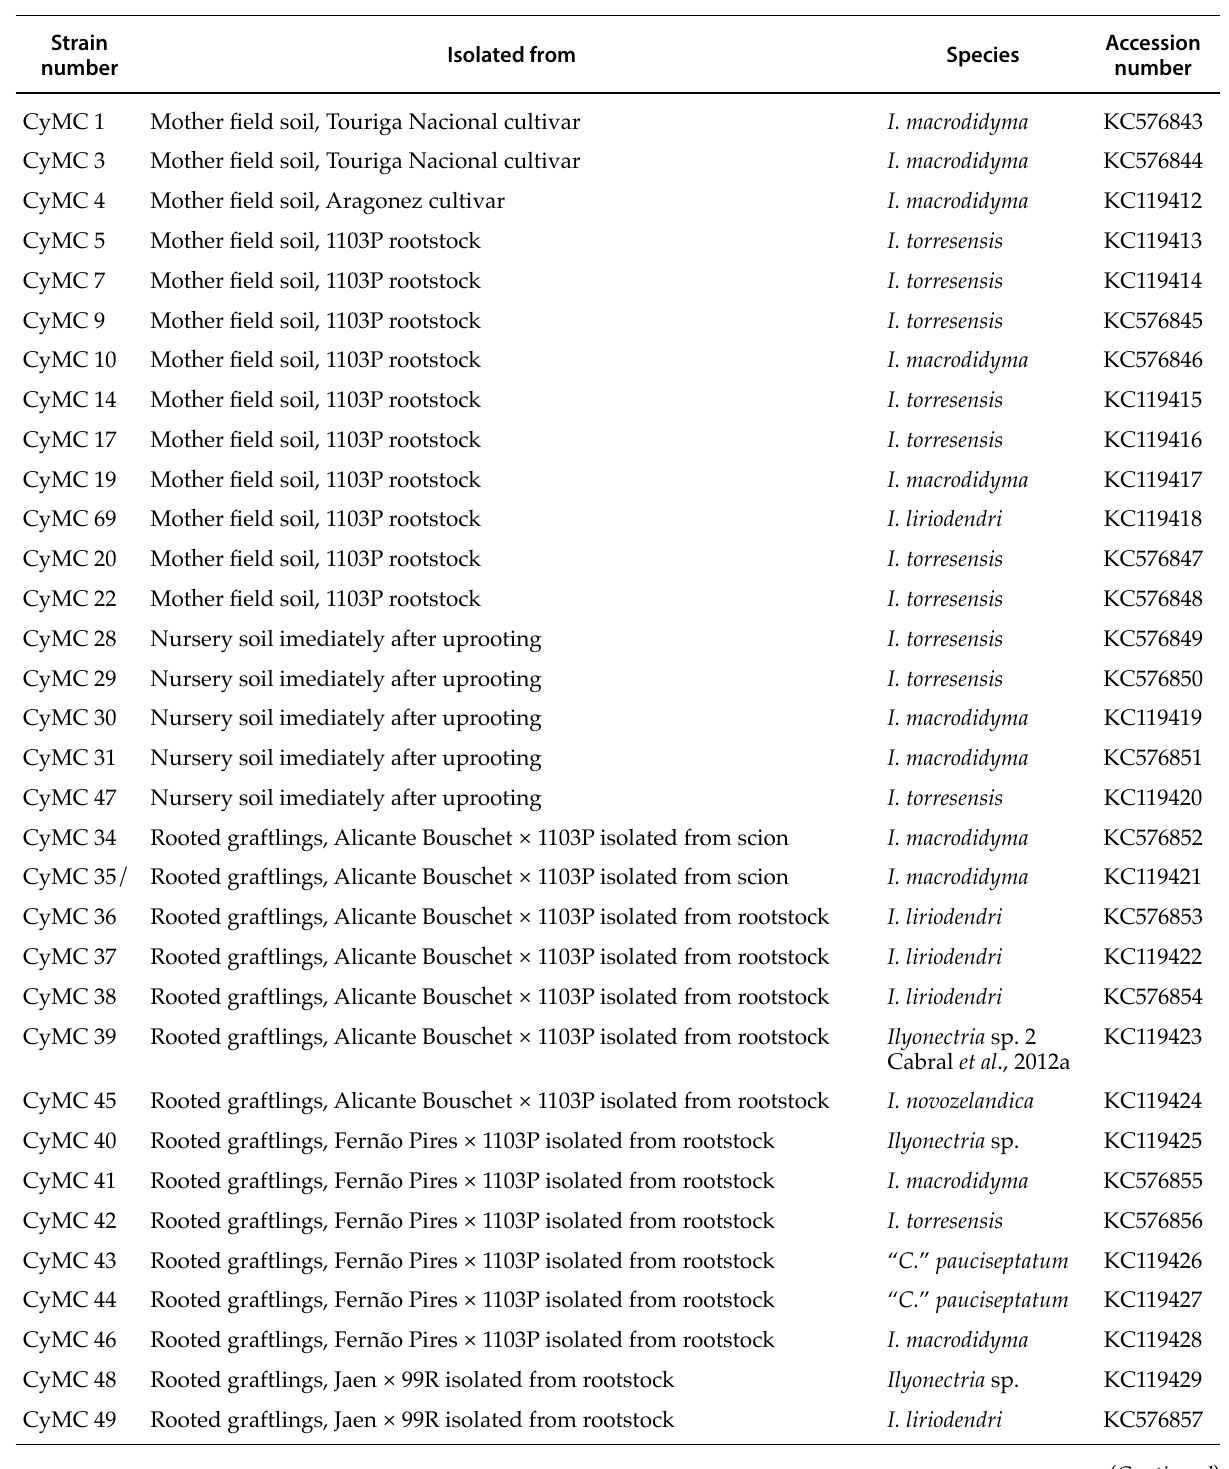
Isolated from Species